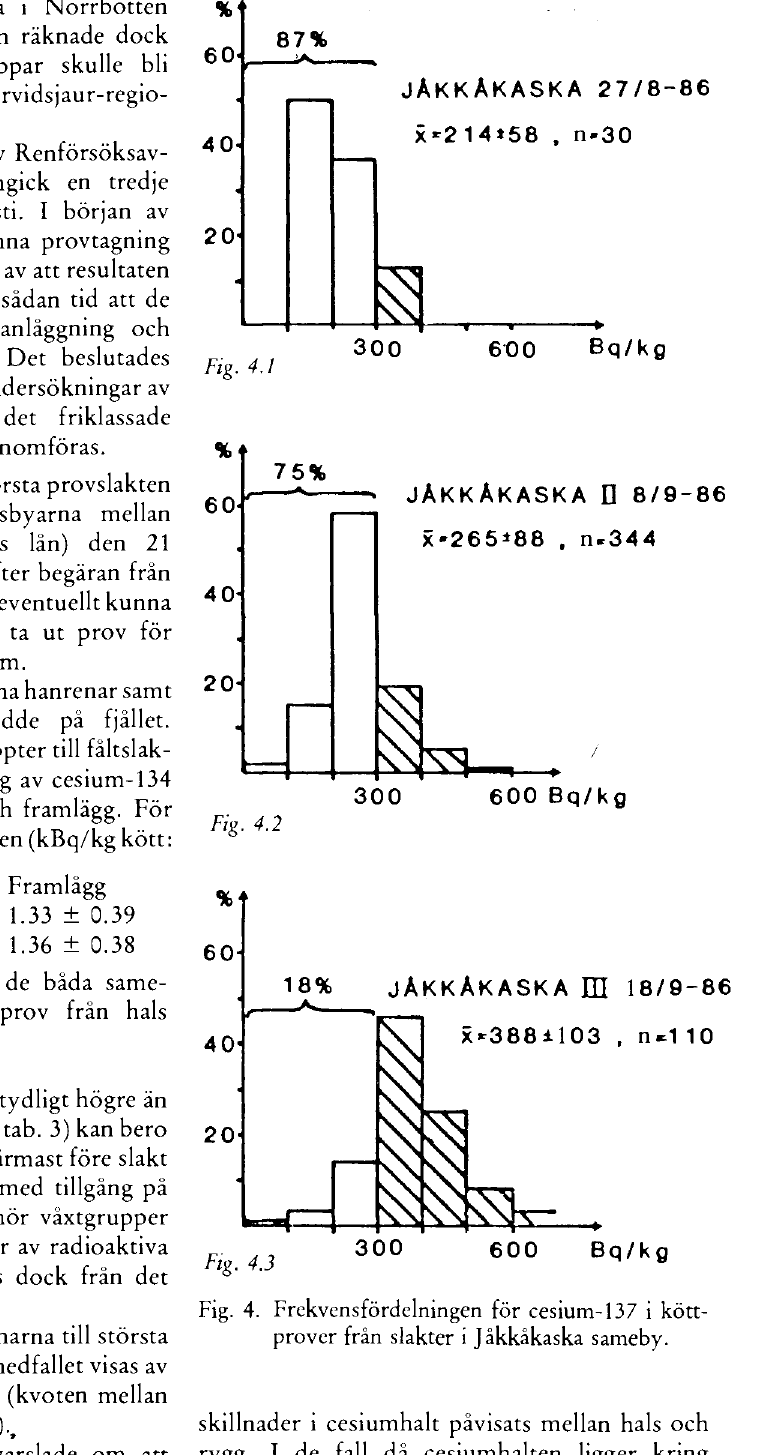
Fig. 4. Frekvensfördelningen for cesium-137 i kött- prover från slakter i Jåkkåkaska